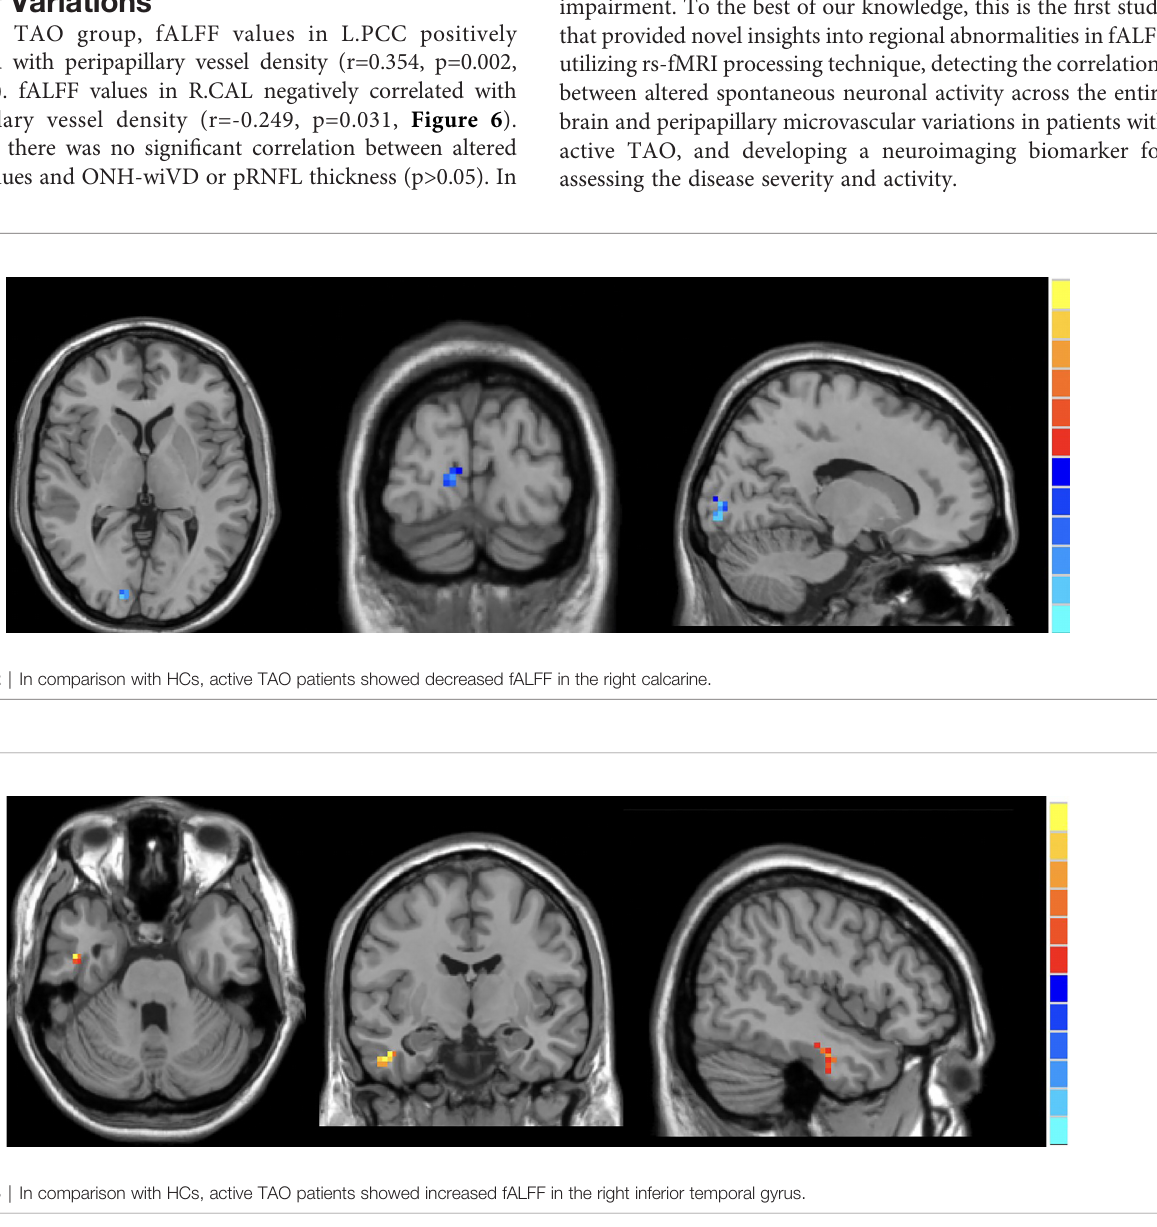
TABLE 2 | Brain regions with signi fi cant differences of fALFF in subjects with active TAO compared to HCs. Brain regions Cluster size T values MNI coordinates TAO>HCs